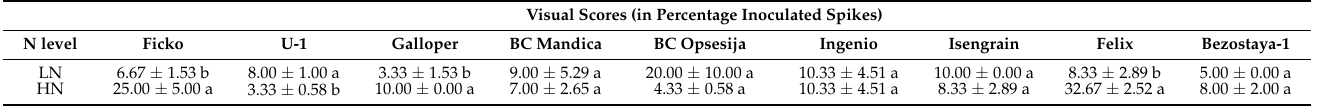
Table 2. Visual scores for Fusarium head blight (FHB) of nine inoculated winter wheat varieties under two different nitrogen levels. Visual Scores ( in Percentage Inoculated Spikes )